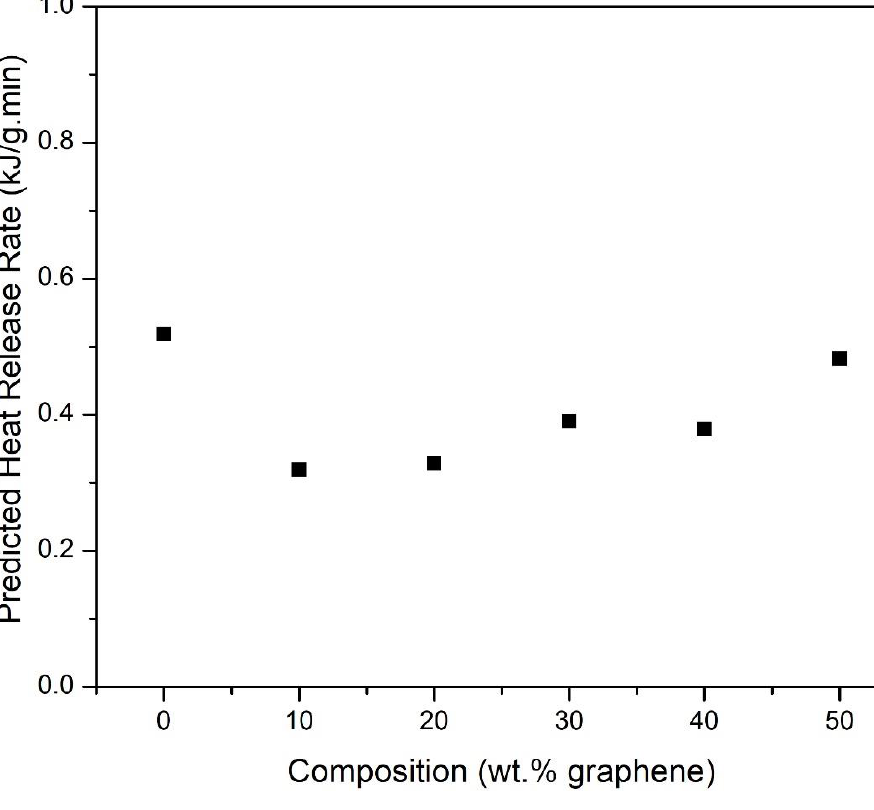
Figure 10. Predicted heat release rates as a function of wt.% graphene.